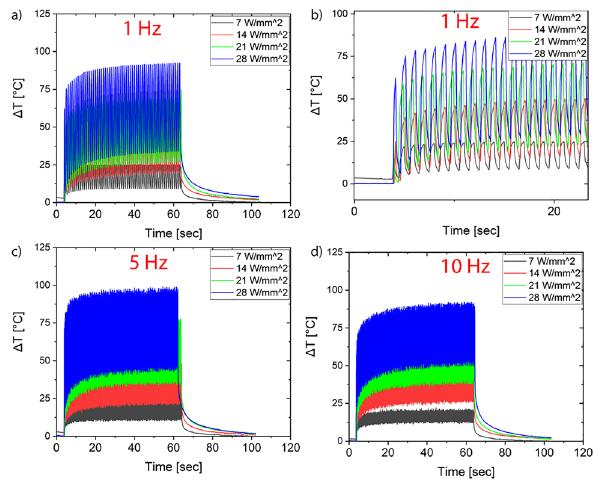
Figure 5: Experimental macroscopic temperature of gold nano flower at different laser ( 𝜆 = 532 nm) intensity and chopper frequency of (a) 1 Hz, (b) zoom of 1 Hz, (c) 5 Hz, and (d) 10 Hz.